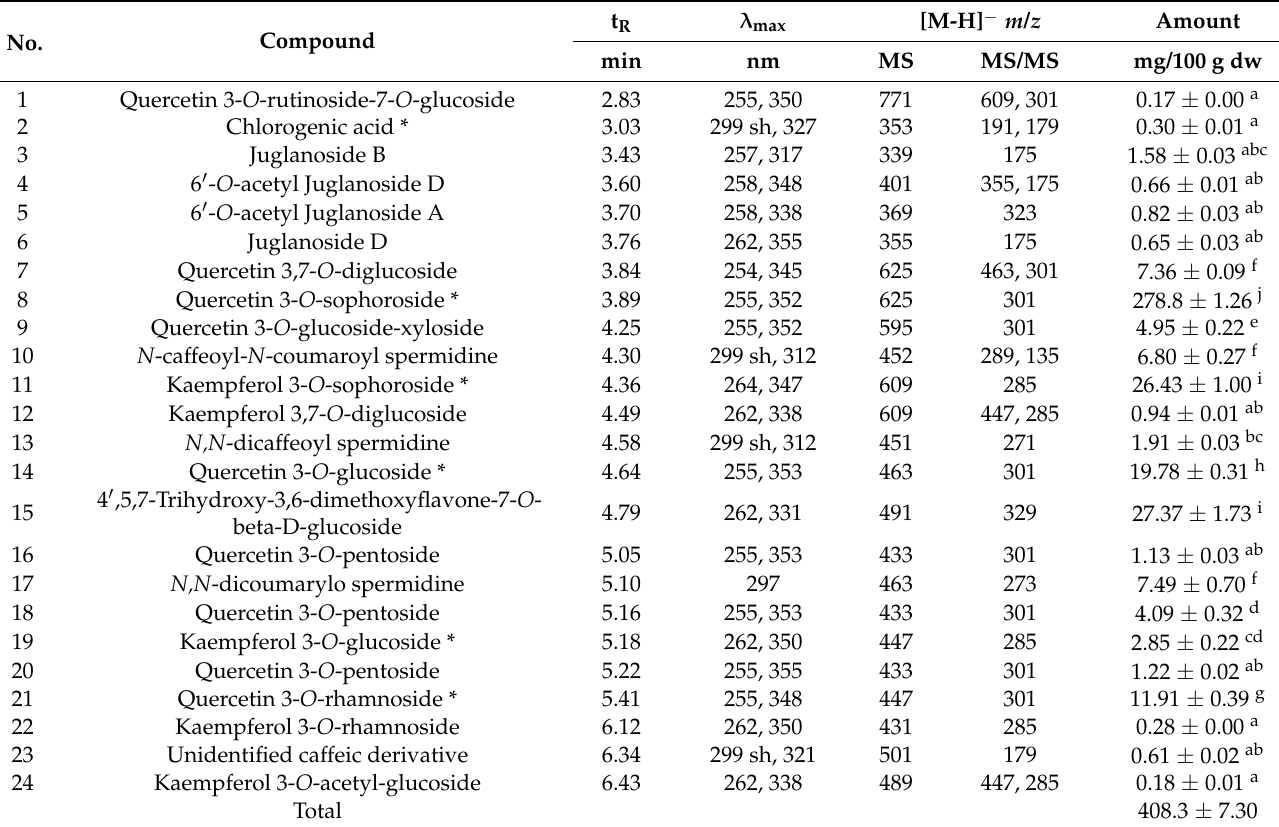
Table 4. Individual phenolic compounds identified by UPLC-PDA-MS/MS in J. regia pollen